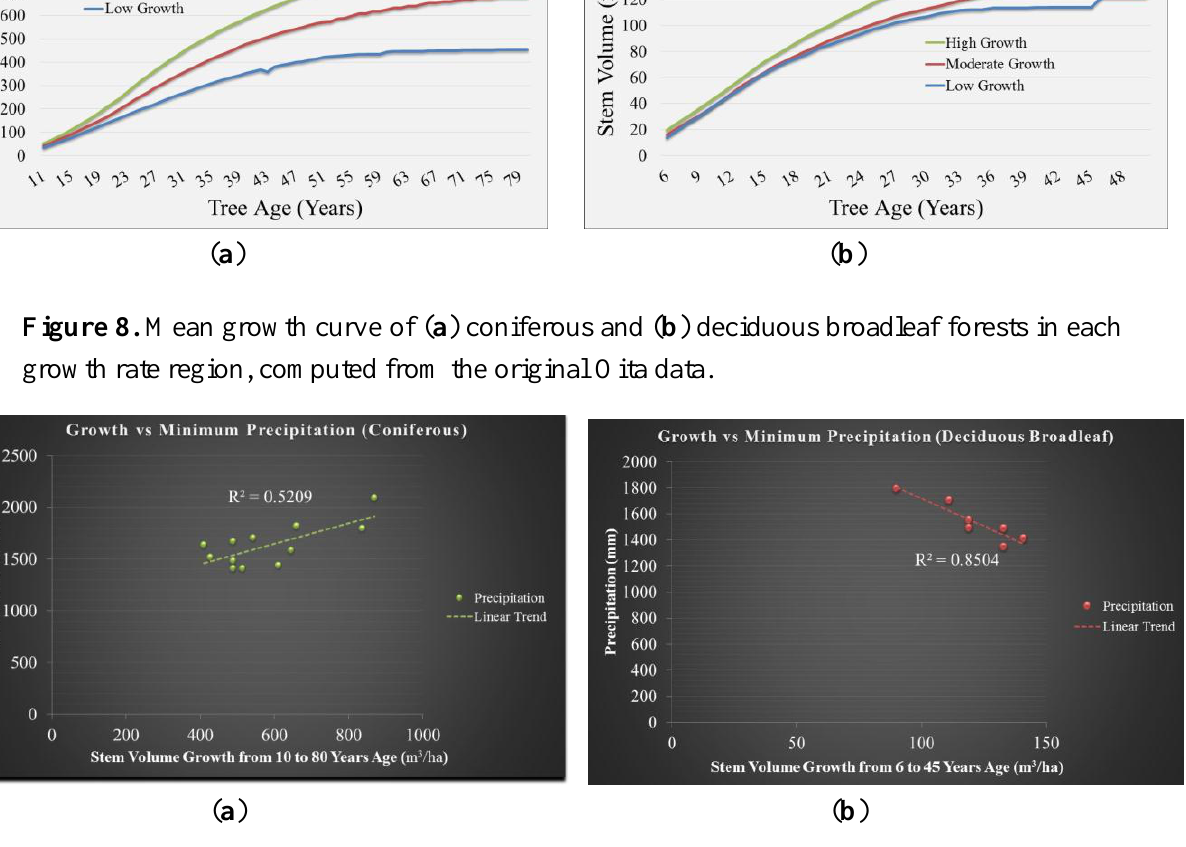
Figure 9. Relationship analysis between annual precipitation and tree growth for ( a ) sugi (cedar) trees and ( b ) kunugi (sawtooth oak) trees.